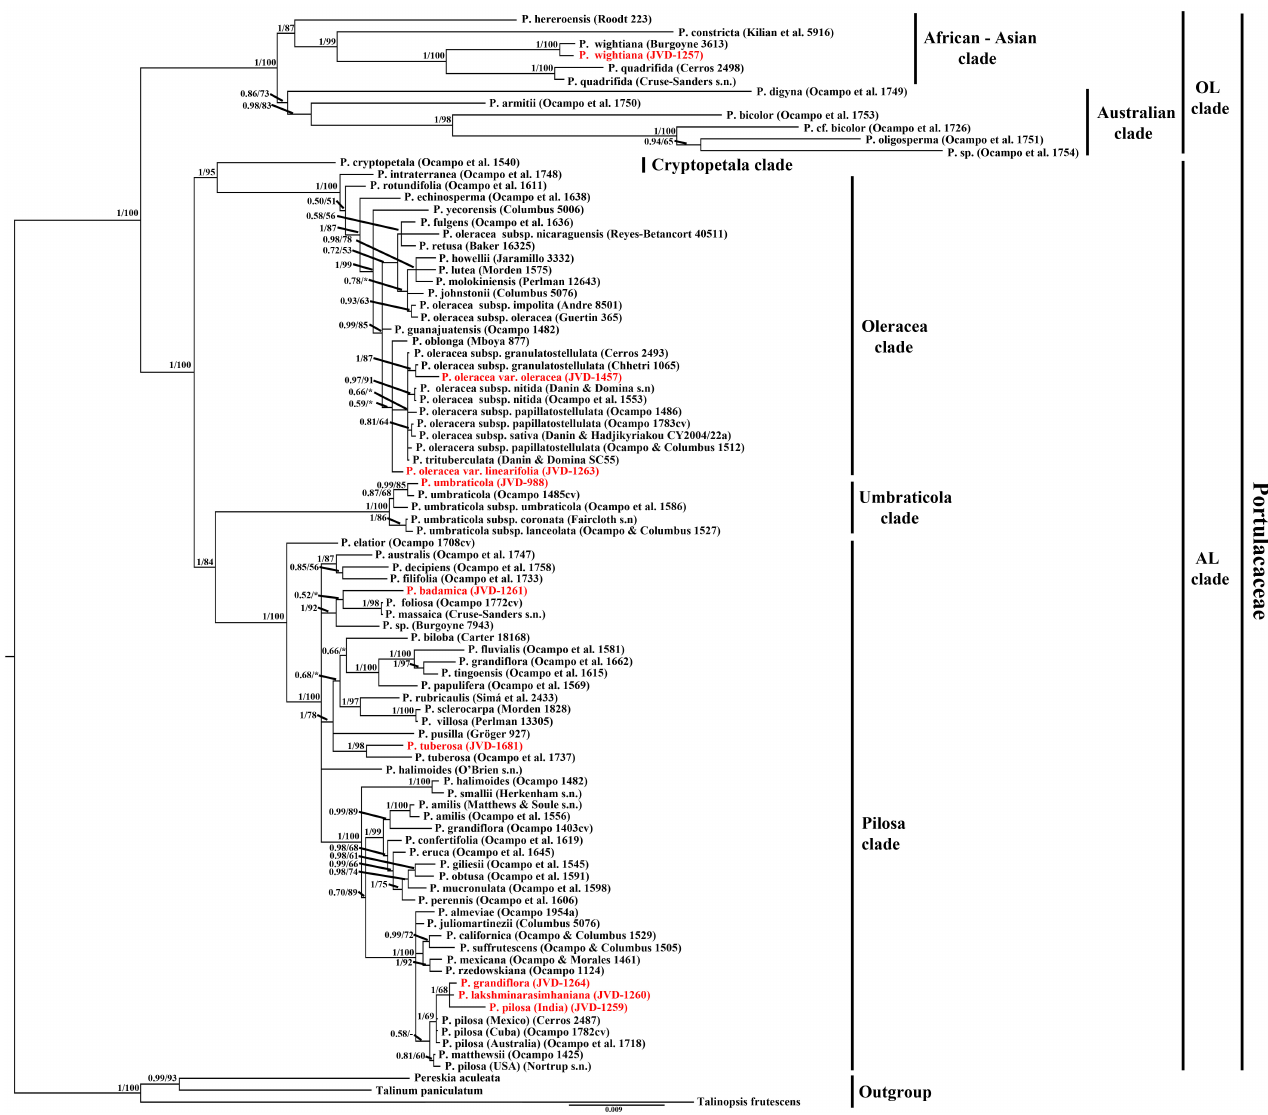
Figure 1. 50% majority-rule consensus Bayesian phylogenetic tree based on combined (ITS + ndh A + ndh F + trn T- psb D) data. Bayesian posterior probability values and maximum likelihood bootstrap values (BPP/ML BS) are provided above branches. Asterisk (*) indicates ML BS values < 50%. The herbarium number of each taxon is in the bracket after the taxa name. The species sampled in this study are in red